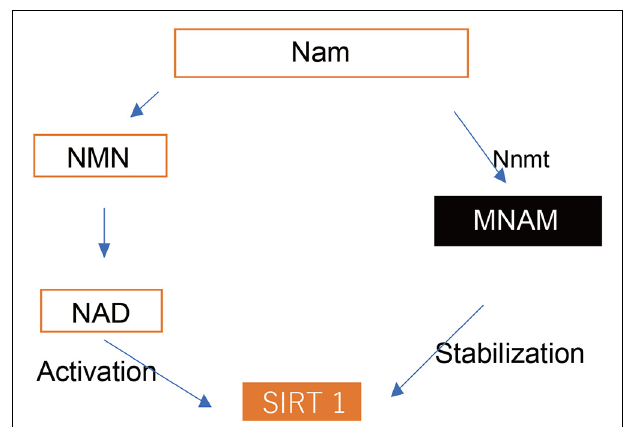
FIGURE 1 | Cascade of Sirt1 activation. SIRT 1, Sirtuin 1; Nam, nicotinamide; NMN, nicotinamide mononucleotide; NAD, nicotinamide adenine dinucleotide; Nnmt, nicotinamide N-methyltransferase; MNAM, N 1